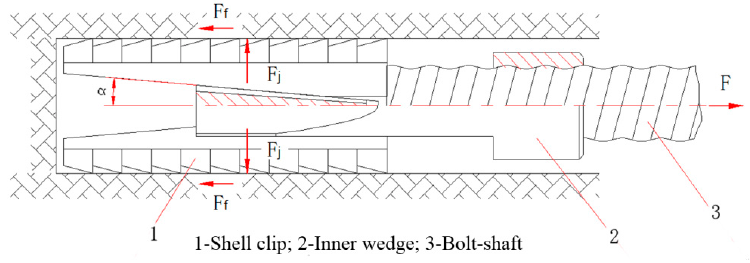
Figure 8. Structure and principle of expansion shell.